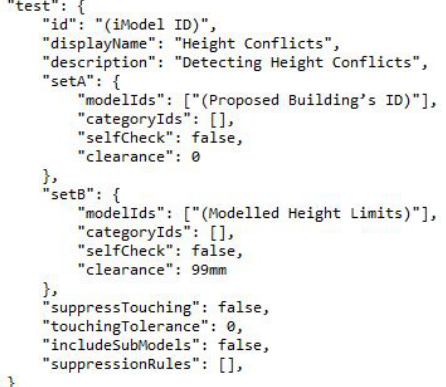
Figure 5 . Defined rule for detecting height limit conflicts.